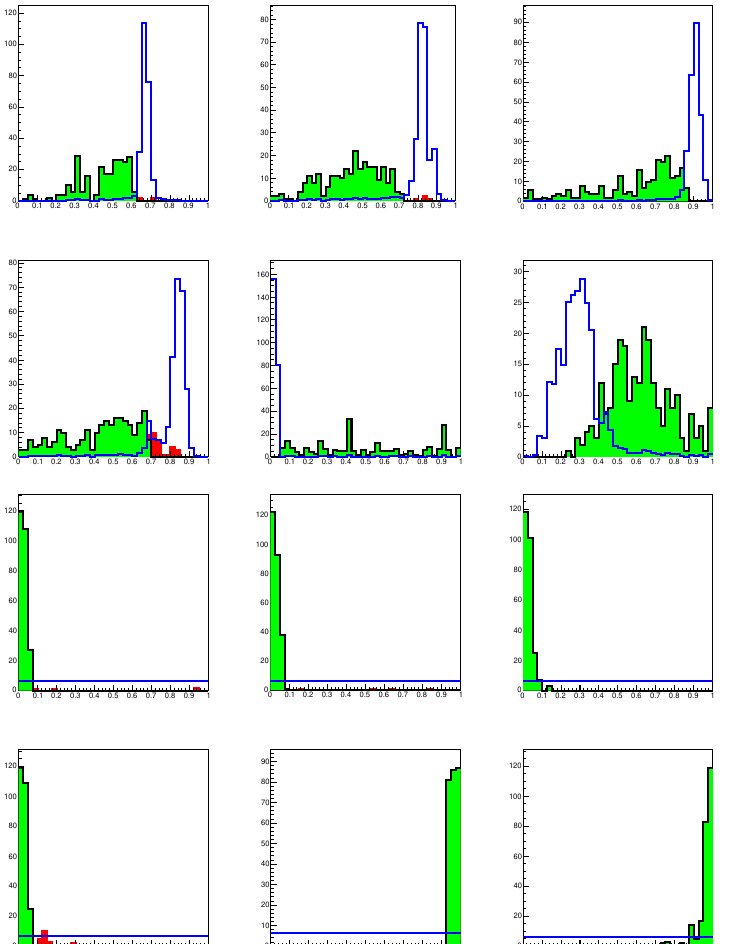
Figure 18 . Marginal distribution of six features selected by RanBoxIter on a sample of 4900 credit card transactions, with 7% fraudulent ones (test 10 in table 11); the top two rows show the data in the original space, and the bottom two show the data in the copula space. The six features are the ones defining the subspace selected by the algorithm, where the highest- R fraudolent transactions. The green distributions refer to the selected events, the blue ones are the original distributions, and red distributions show transactions that do not belong to the box solely because of the value of the displayed